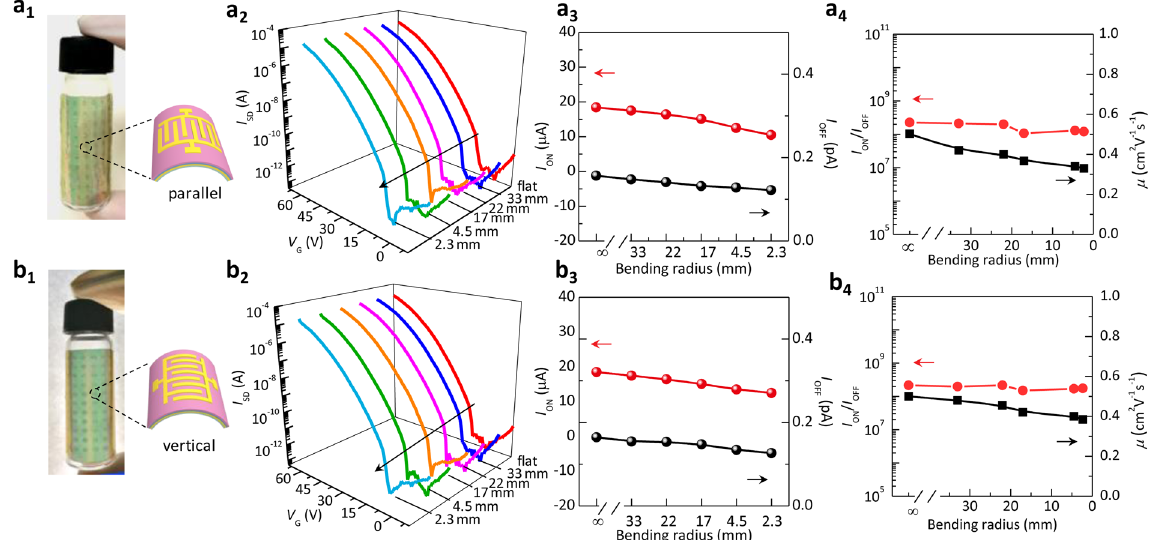
Figure 5. Typical photograph and schematic images, typical transfer curves, I ON , I OFF , mobility and I ON / I OFF of the device at strain bending ( a 1 –a 4 ) parallel and ( b 1 – b 4 ) vertical to channel length. The bending radius is from 3.3 to 0.23